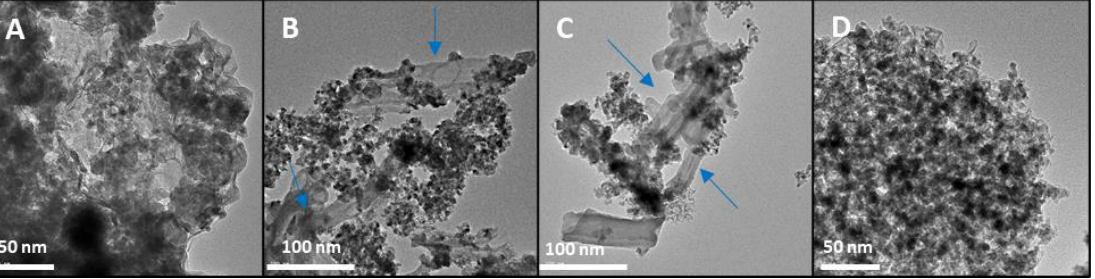
Figure 6. TEM images. ( A ) Cu/ZnO bimetallic nanoparticles with PVP; ( B , C ) Cu/ZnO/polypyrrole nanotubes; ( D ) Cu/ZnO/zeolite. The arrows indicate the polypyrrole nanotubes. nanotubes; ( D ) Cu/ZnO/zeolite. The arrows indicate the polypyrrole